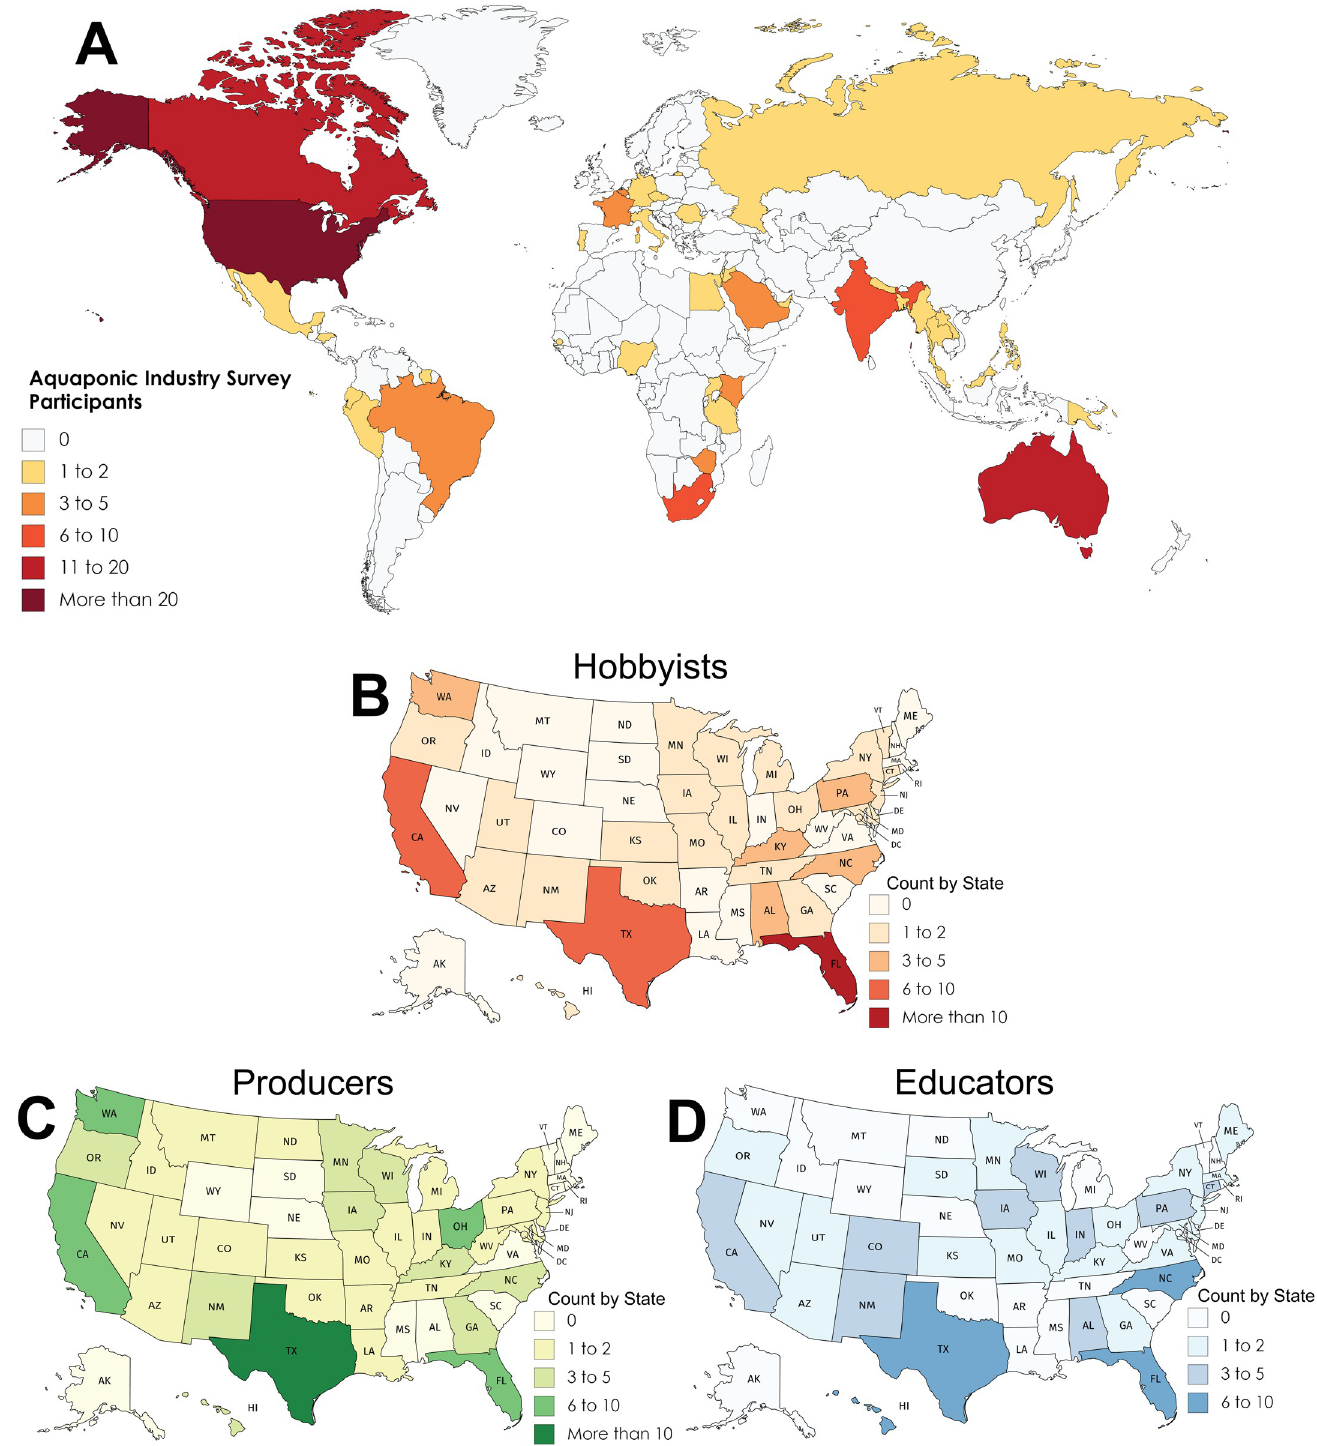
Fig 1. Geographical distribution of aquaponic industry survey participants. Maps show the number of respondents by country (A), and hobbyists (B), producers (C), and educators (D) by state within the United States. Maps were generated using Mapchart.net, licensed under CC BY 4.0.